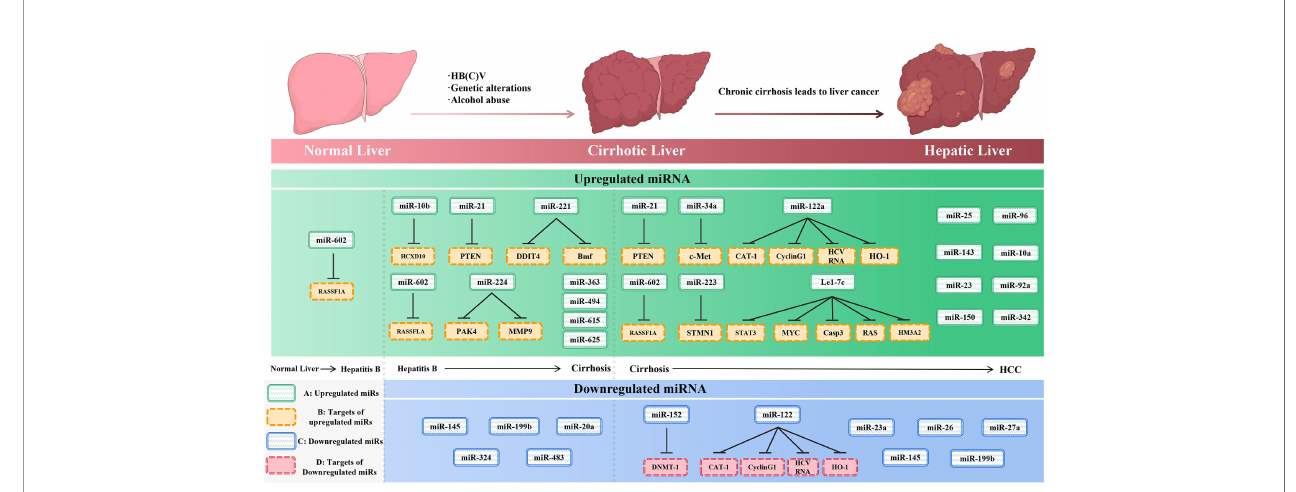
FIGURE 2 | The initiation and development of hepatocellular carcinoma (left) and the expression of miRNAs and their targets (right) during the development of liver cancer. (A) -upregulated miR-NAs, (B) -targets of upregulated miRNAs, (C) -downregulated miRNAs, and (D) -targets of downregulated